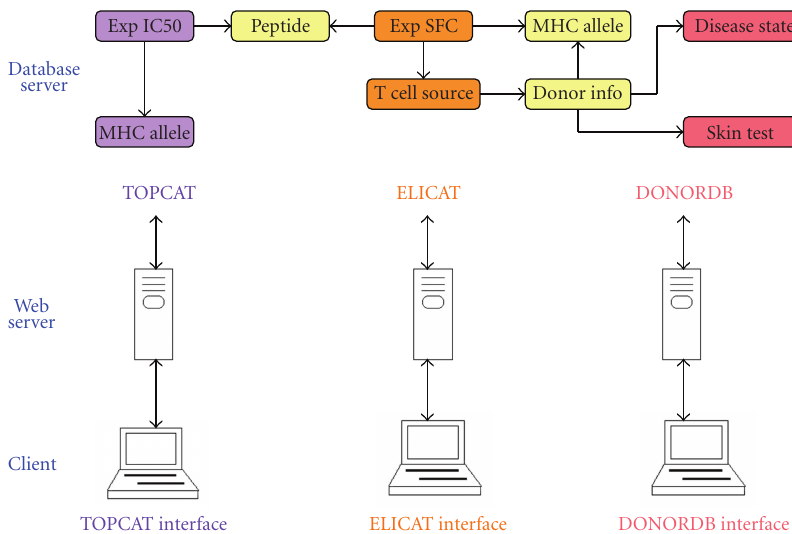
Figure 2: The architecture of IMMUNOCAT system. IMMUNOCAT is an integration of three web accessible relational databases. DONORDB is designed for data collected during donor enrollment and clinical tests. ELICAT stores the data from T cell assays performed using donor blood samples stimulated with a set of allergen derived peptides. TOPCAT stores the MHC-peptide binding data of the same set of peptides. Simplified database structures are presented at the top of the figure. Arrows represent the links between database tables. Tables shared by two databases are colored yellow. In DONORDB, donor information table is linked to skin test, disease state, and MHC allele tables. In ELICAT, table of experimental spot forming cell (SFC) is linked to peptide, T cell source, and MHC allele tables. In TOPCAT, table of experimental IC50 is linked to peptide and MHC allele tables. DONORDB is connected with ELICAT using donor IDs and MHC allele IDs. ELICAT and TOPCAT are connected with each other using shared peptide